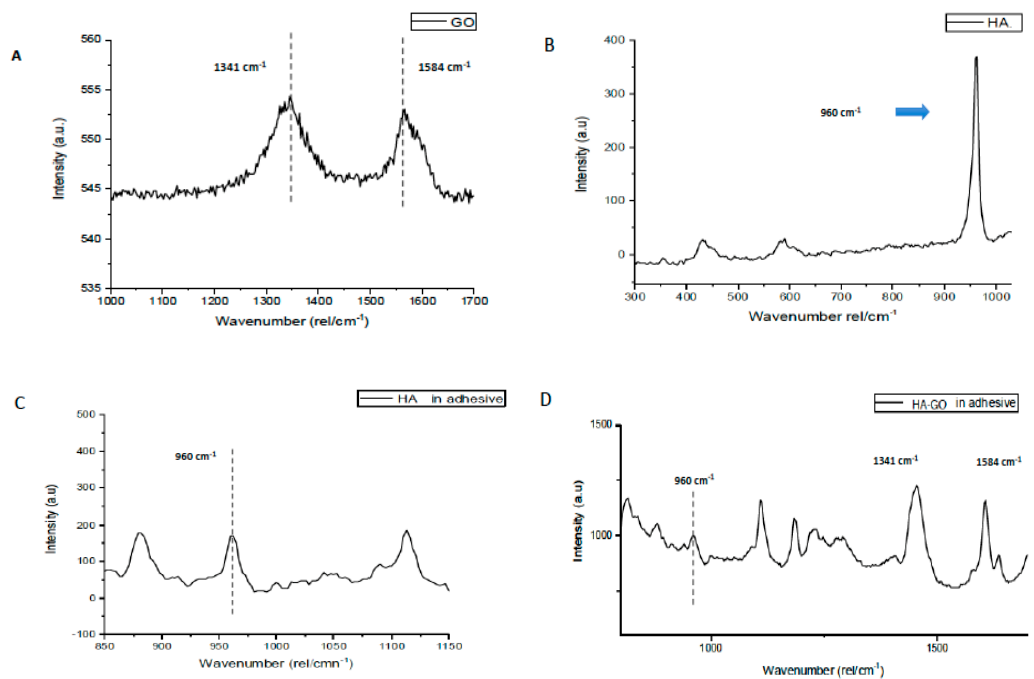
Figure 4. Raman spectra of ( A ) synthesized GO nanoparticles showing characteristic D and G bands which are two prominent peaks at 1341 and 1584 cm − 1 . Usually, the G mode is assigned to the vibration of sp2-hybridized carbon, while the D mode is related to the sp3-hybridized carbon and deficiencies relevant with grain boundaries and vacancies in GO. ( B ) Raman spectra of the hydroxyapatite nano particles showing chemical groups of phosphate ( υ 1 PO 4 ~960 cm − 1 ). ( C ) HAP within dentin adhesive showed weaker phosphate bonds intensities at 960 cm − 1 . ( D ) wiTH GO addition in dentin adhesive with HAP, the characteristic peaks could be seen for both nanoparticles at their respective